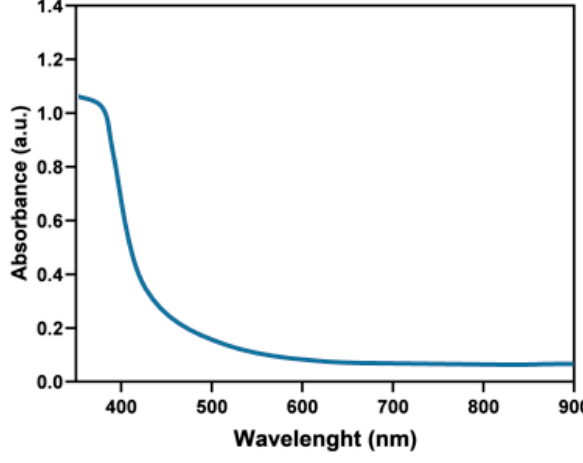
Figure 4. UV-Vis spectrum of AuPt NCs.